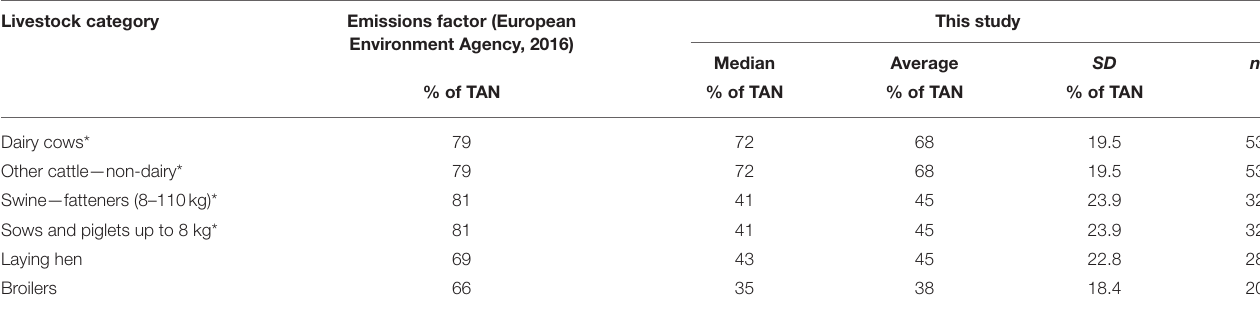
TABLE 8 | Ammonia emission from solid manure applied in the field given as a % of TAN content in the manure applied in the field (references to articles providing data for each category can be found in the Excel spreadsheets in the Supplementary Material ). Livestock category